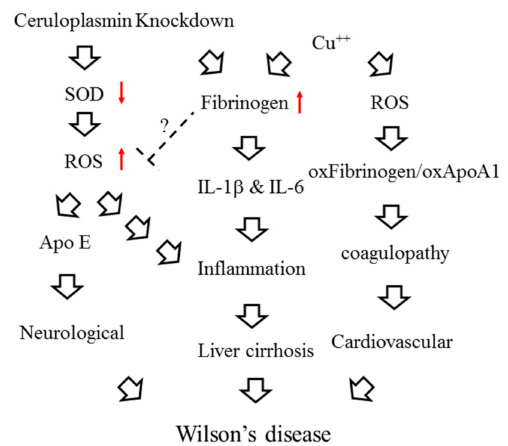
Figure 5. Schematic diagram of the interactions between ceruloplasmin, fibrinogen and oxidative stress. The red arrow up means increase and the red arrow down indicates